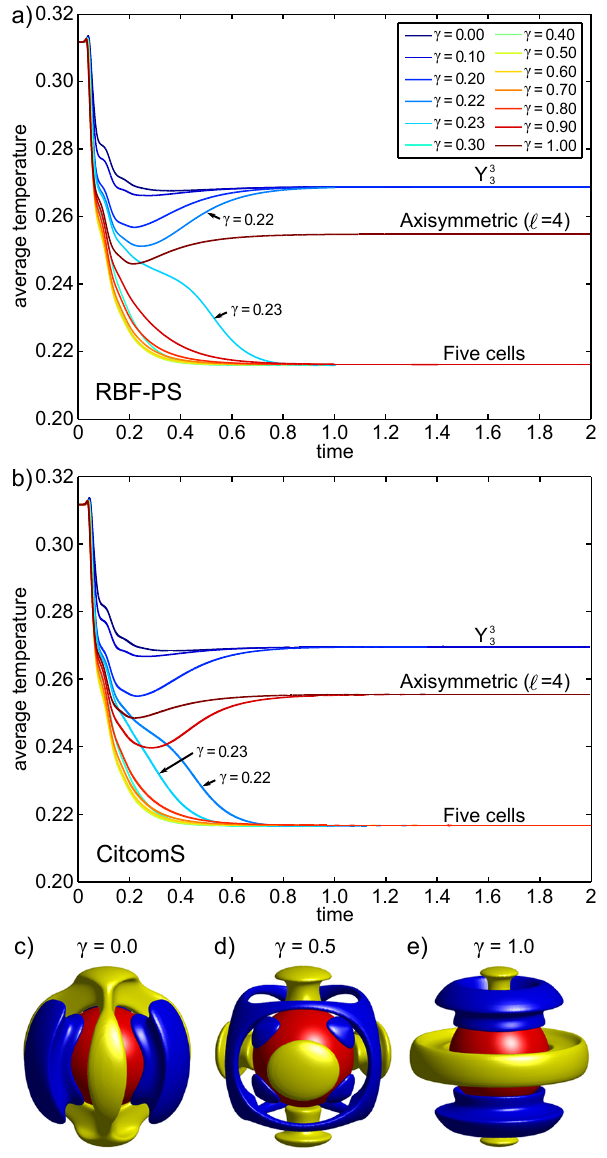
Figure 12. Time traces of the evolution of the average temperature as a function of the parameter at Ra = 7000 for (a) the RBF-PS model and (b) CitcomS. (c–e) show the final convection patterns for each of these models, with (c) γ = 0, (d) γ = 0 . 5, and (e) γ = 1.